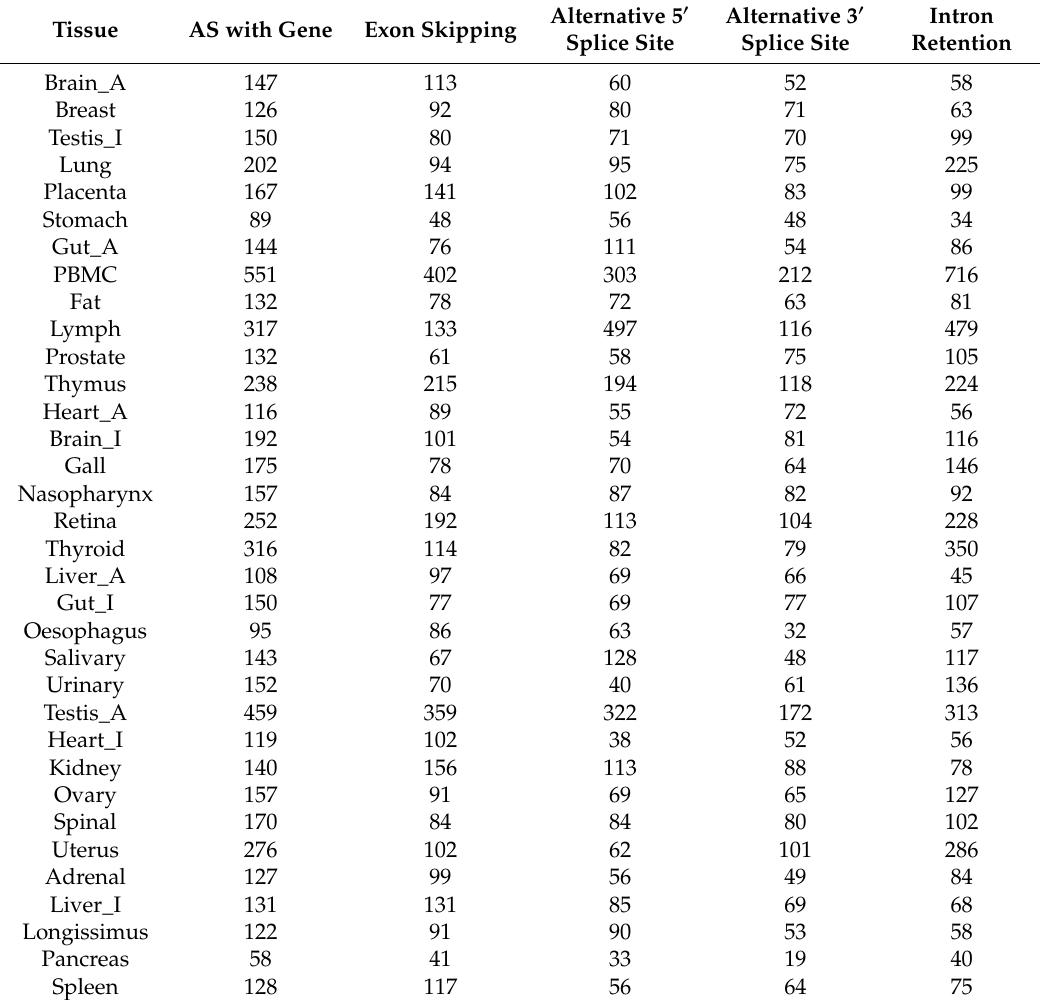
Table 1. Distribution of tissue ASE types in different tissues.